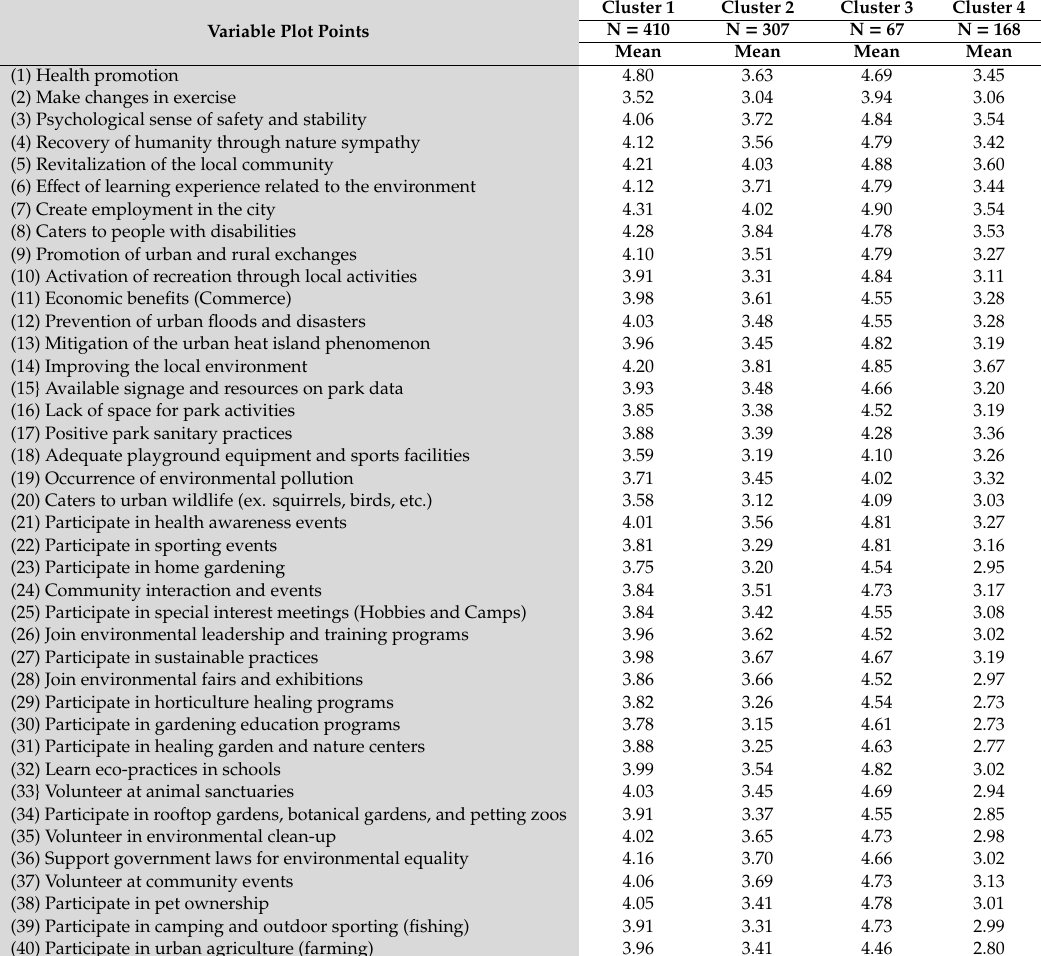
Table 2. Parallel analysis variable plot points of participant profiles (left to